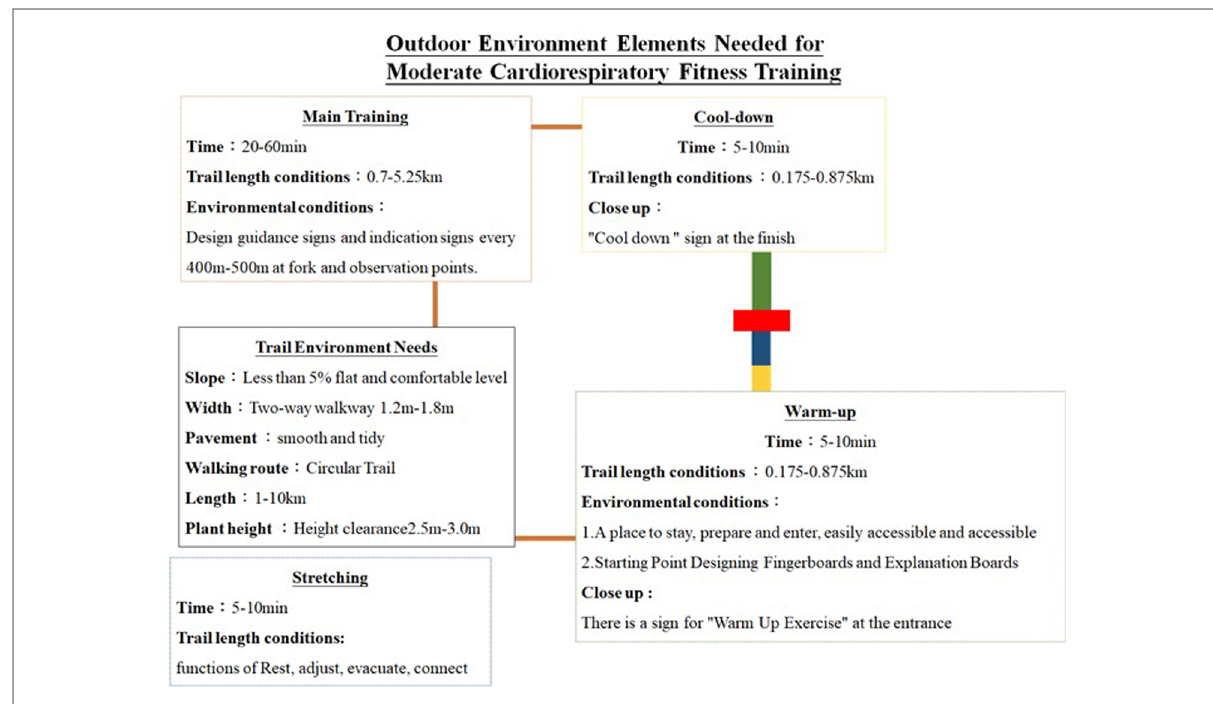
FIGURE 2 Outdoor environment elements needed for moderate cardiorespiratory fi tness